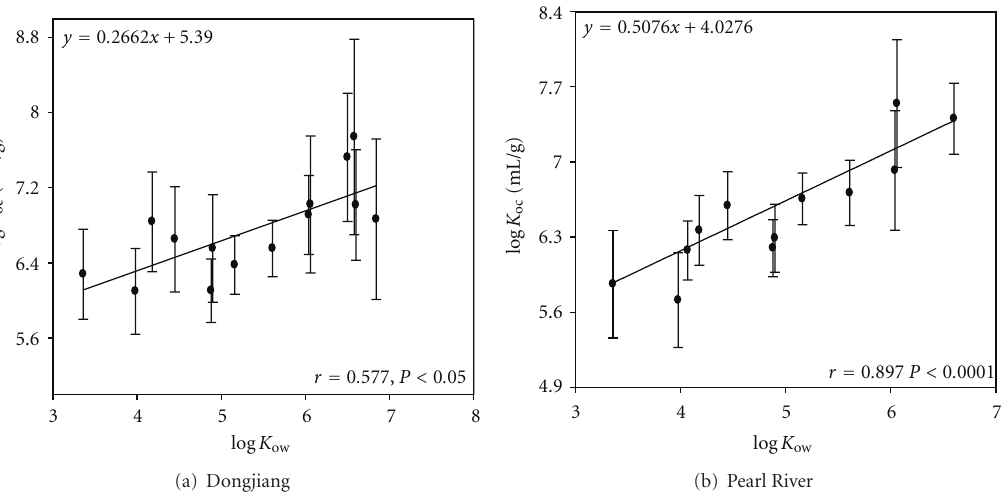
Figure 9: Relationship between log K oc and log K ow for PAHs.